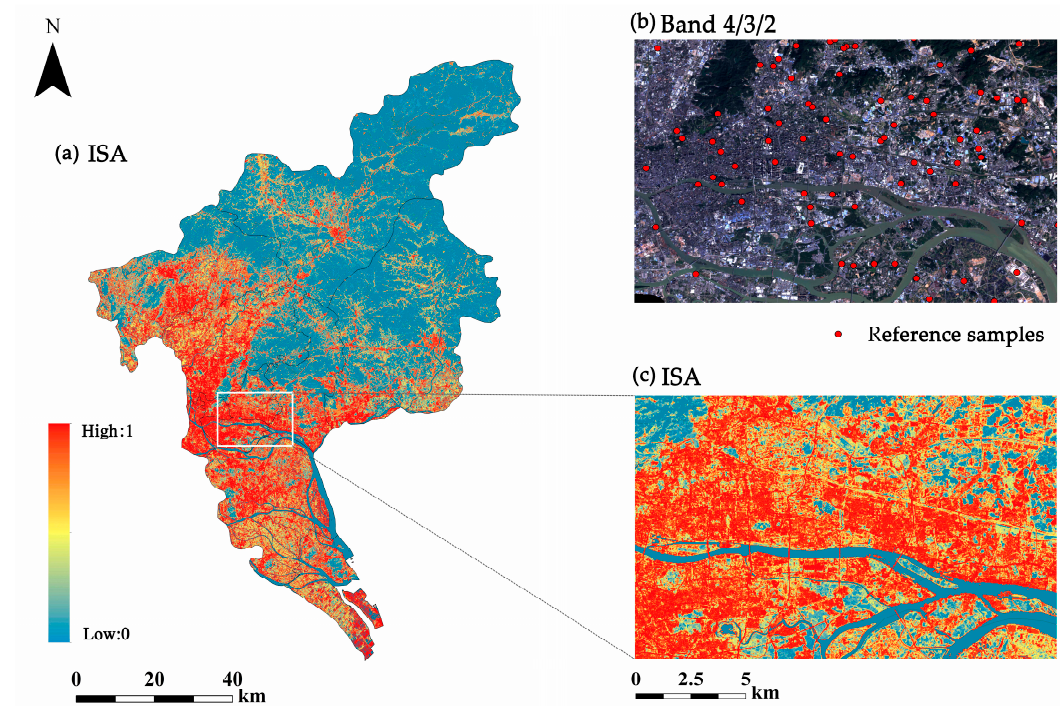
Figure 8. Estimated results of ISA. (ISA: impervious surface area; ( a ) ISA of Guangzhou; ( b ) Reference samples on Landsat 8 (Band4/3/2) in representative urban areas of IS; ( c ) ISA of representative urban areas).